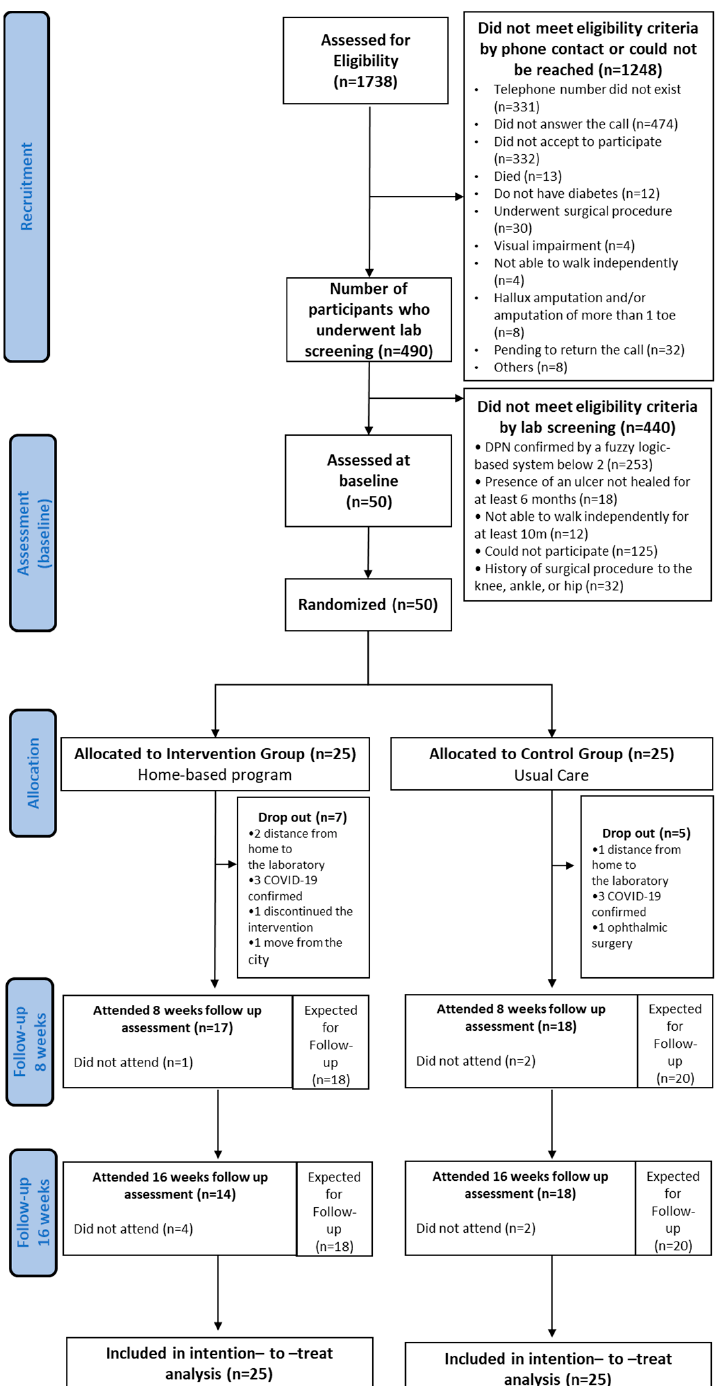
Figure 1. Flowchart of participant recruitment, assessments, and follow ‐ up process of FOCA ‐ II trial. A significant interaction effect was observed after 8 weeks for hip flexor moment at heel strike that was higher in the control group compared to IG (interaction effect p = 0.010) (Table 4). Within-group analysis showed that control group participants reduced the hip flexor moment at 16 weeks compared to 8 weeks (time effect p = 0.007) (Figure 2A). A within-group analysis also revealed a greater hip extensor moment at push off and knee flexor moment at push off at 16 weeks compared to baseline and 8 weeks for the control group (time effect p < 0.001 and p = 0.009, respectively) (Figure